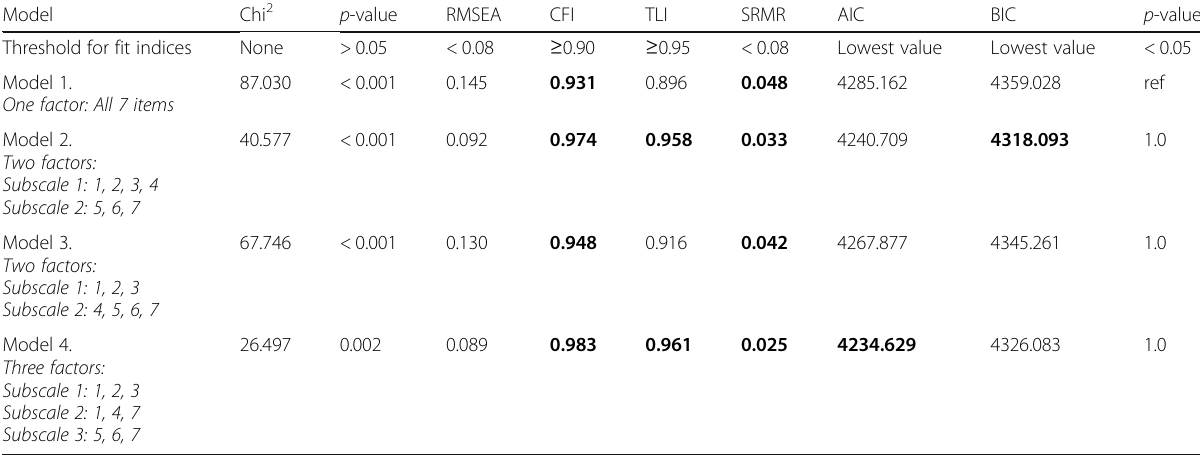
Table 2 Fit indices of confirmatory factor analyses in different Insomnia Severity Index factor models ( n = 249)